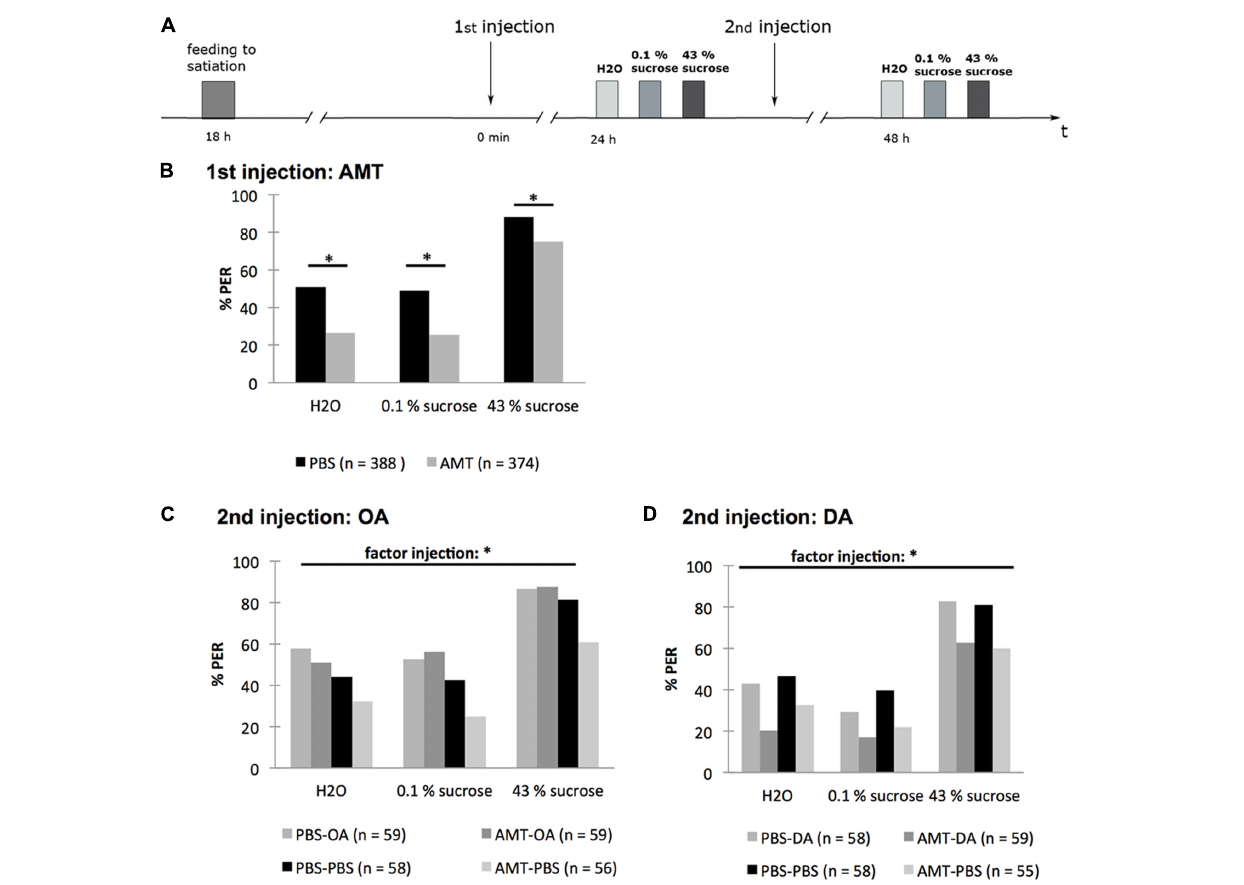
FIGURE 9 | Octopamine but not dopamine rescues the effect of α -methyl- p -tyrosine (AMT) on the PER of honeybees. (A) Schematic overview of the experiment. Bees were fed to satiation with 30% (w/v) sucrose solution (0.88 M) 18 h before injection of AMT (first injection). Twenty-four hours following AMT injection the PER was tested touching the antennae with water (H 2 O), 0.1% (w/v) sucrose solution (2.9 mM) (0.1% sucrose), 43% (w/v) sucrose solution (1.25 M) (43% sucrose). Following this test, subgroups of bees were injected with octopamine (OA), dopamine (DA), or PBS. Another 24 h later the PER was tested again with water (H 2 O), 0.1% (w/v) sucrose solution (2.9 mM) (0.1% sucrose), 43% (w/v) sucrose solution (1.25 M) (43% sucrose). (B) One day after injection of AMT or PBS significant differences between groups were found. (C) Injection of OA rescued the AMT effect. (D) Injection of DA did not rescue the AMT effect. ∗ p < 0.05. Number of bees appears in